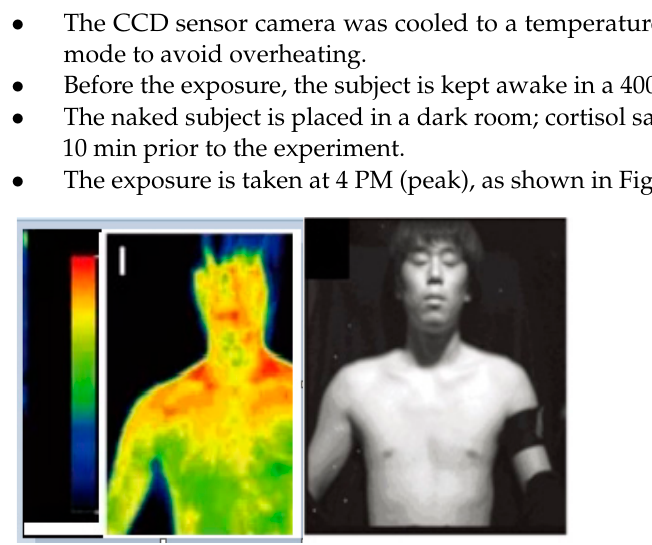
Figure 5. Schematic illustration of experiment setup.